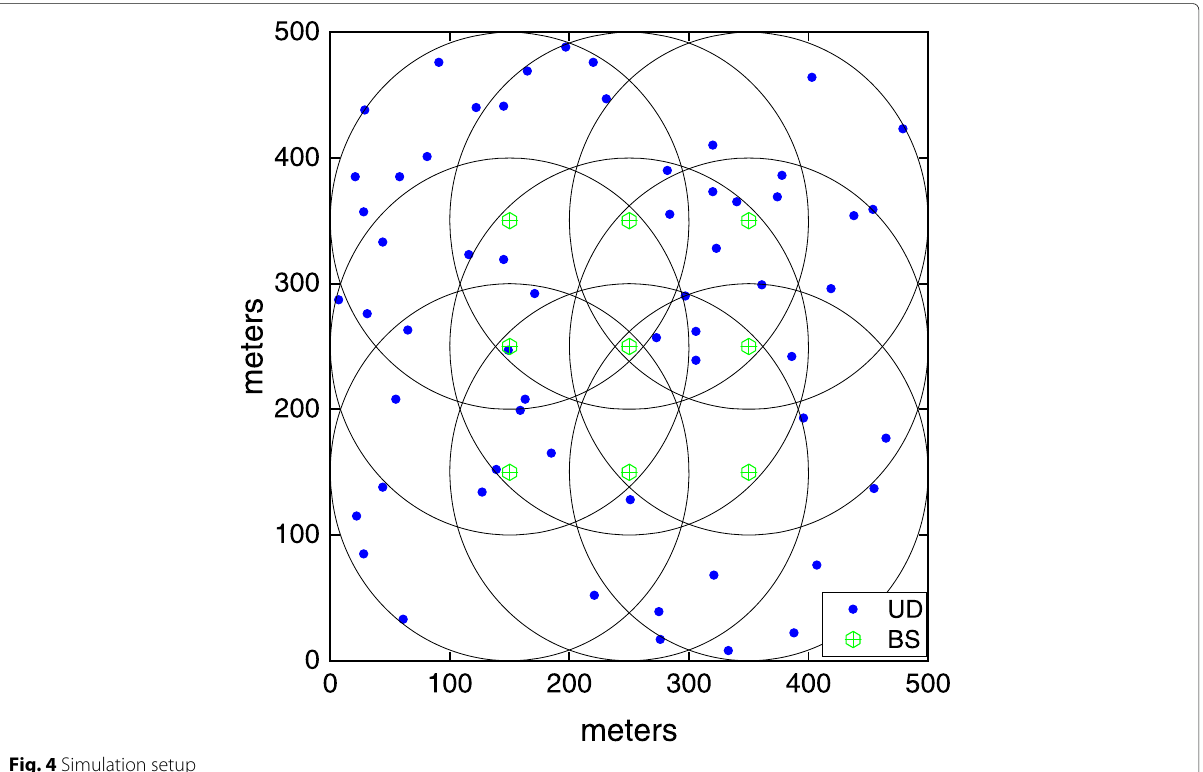
Fig. 4 Simulation setup